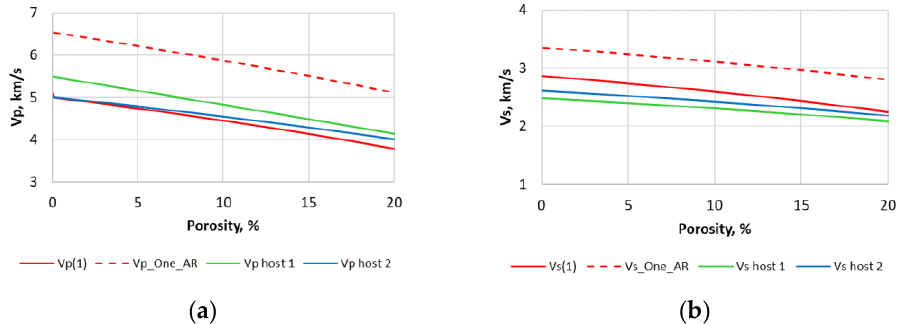
Figure 18. Comparison of the predicted velocities ( a ) Vp and ( b ) Vs for fluid-saturated rocks obtained with four RP models for Sample 1. The solid red lines correspond to the prediction based on the RP model with dual porosity (pores and microcracks). The dashed red lines correspond to the RP model prediction with a single aspect ratio for all voids (“as simple as possible” model). The green and blue curves correspond to predictions for models host 1 and host 2 described in the text. The parameters of all RP models are inverted from Dataset 1.